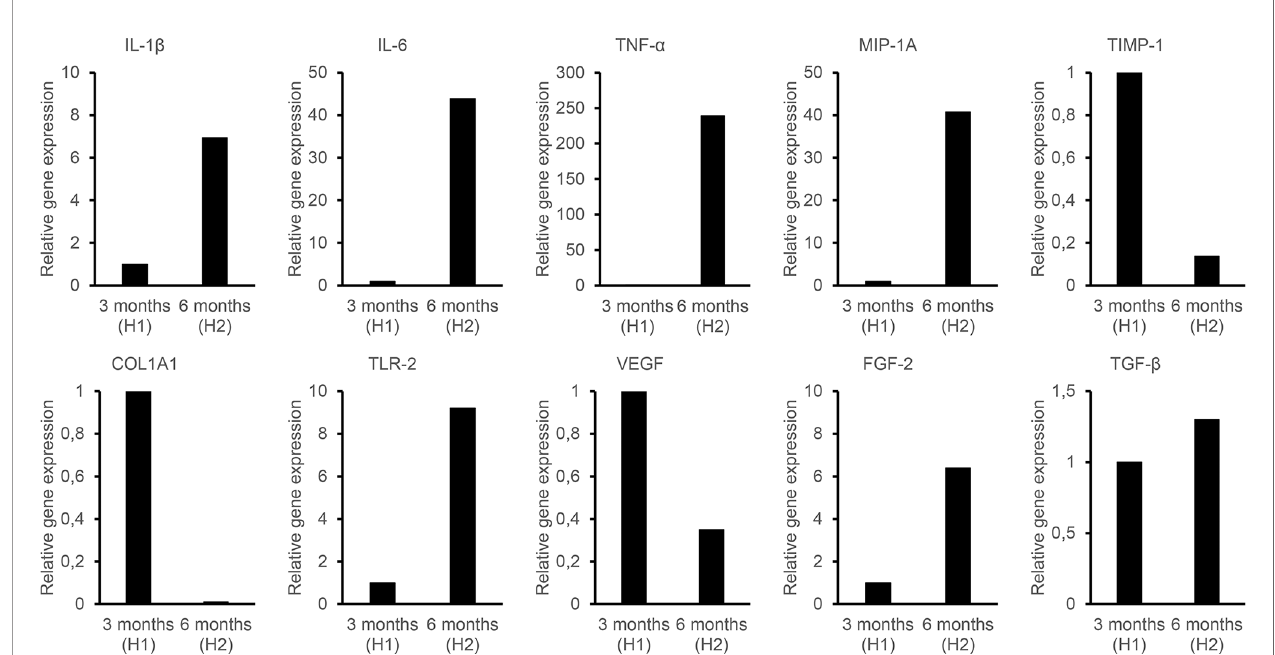
FIGURE 4 | Quantitative PCR analysis to evaluate the relative expression of genes related to in fl ammation (IL-1b, IL-6, IL-8, TNF-a, IL-17, IL-10, TGF-ß, MIP-1a), extracellular matrix (MMP-9, TIMP-1, COL1a1), vascularization (VEGF, FGF-2), and bacterial infection (TLR-2). H1 indicates the Holgers 1 score according to the Holgers Index scoring. H2 indicates the Holgers 2 score, which was de fi ned as an episode of soft tissue in fl